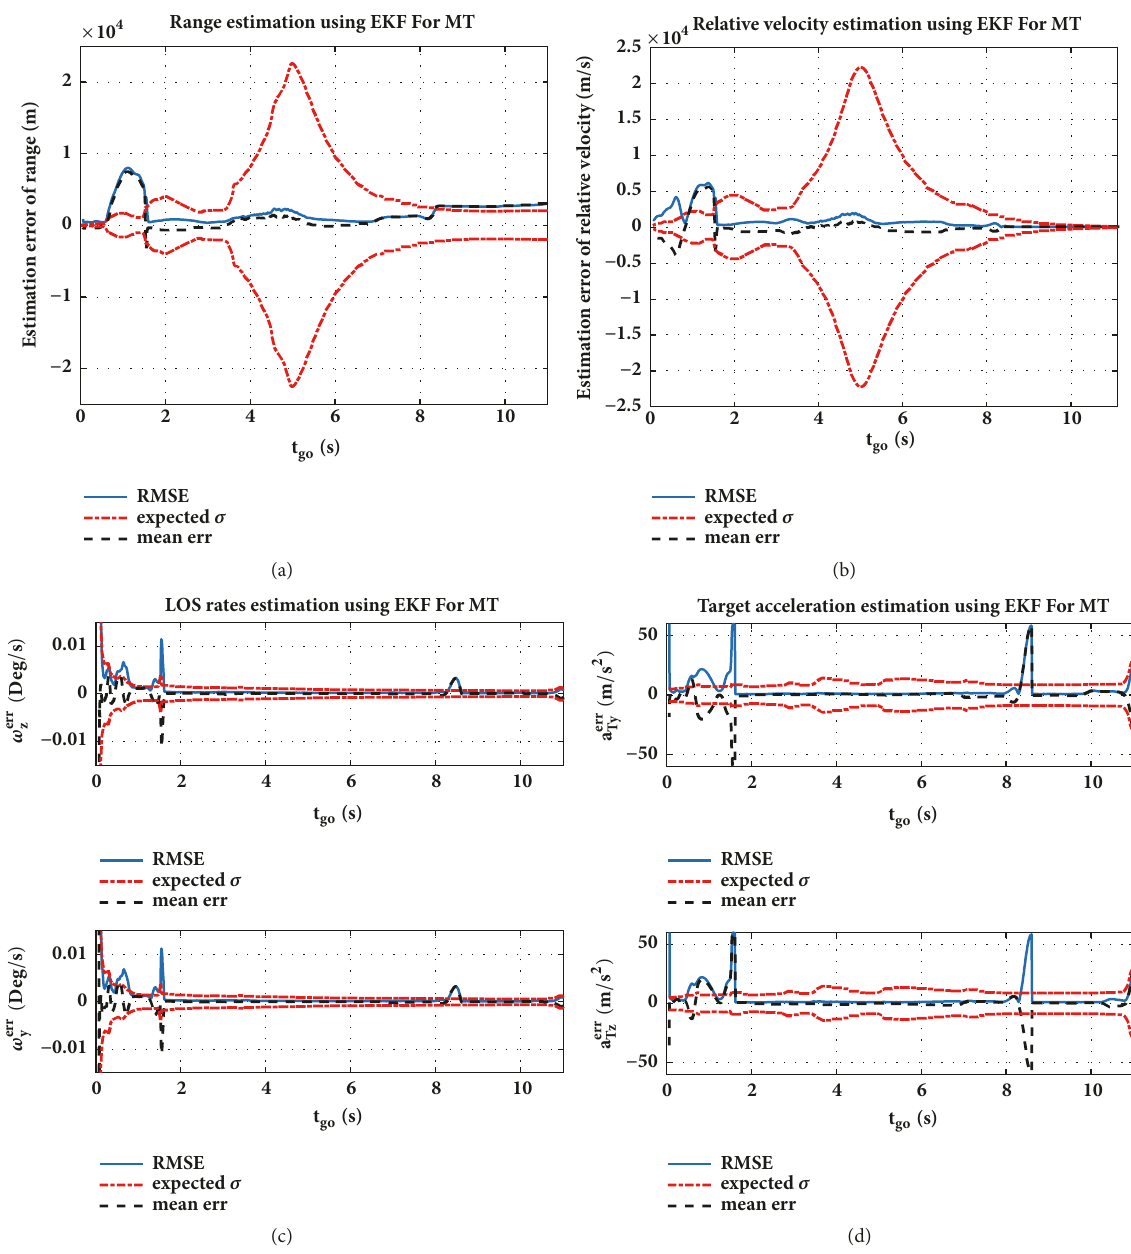
Figure 11: (a) Range estimation errors using EKF for MT. (b) Relative velocity estimation errors using EKF for MT. (c) LOS rates estimation errors using EKF for MT. (d) Target acceleration estimation errors using EKF for